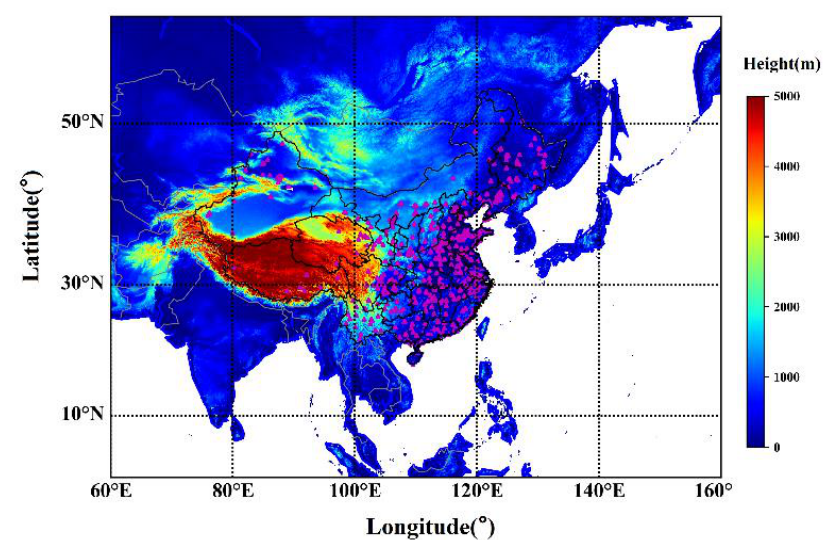
Figure 1. The study domain and overlapped digital elevation model from MERSI-II Level 1 GEO1K. The sea surface is shown in white. The national PM 2.5 monitoring stations employed by the Ministry of Environmental Protection on 22 October 2020 are depicted as the magenta-colored